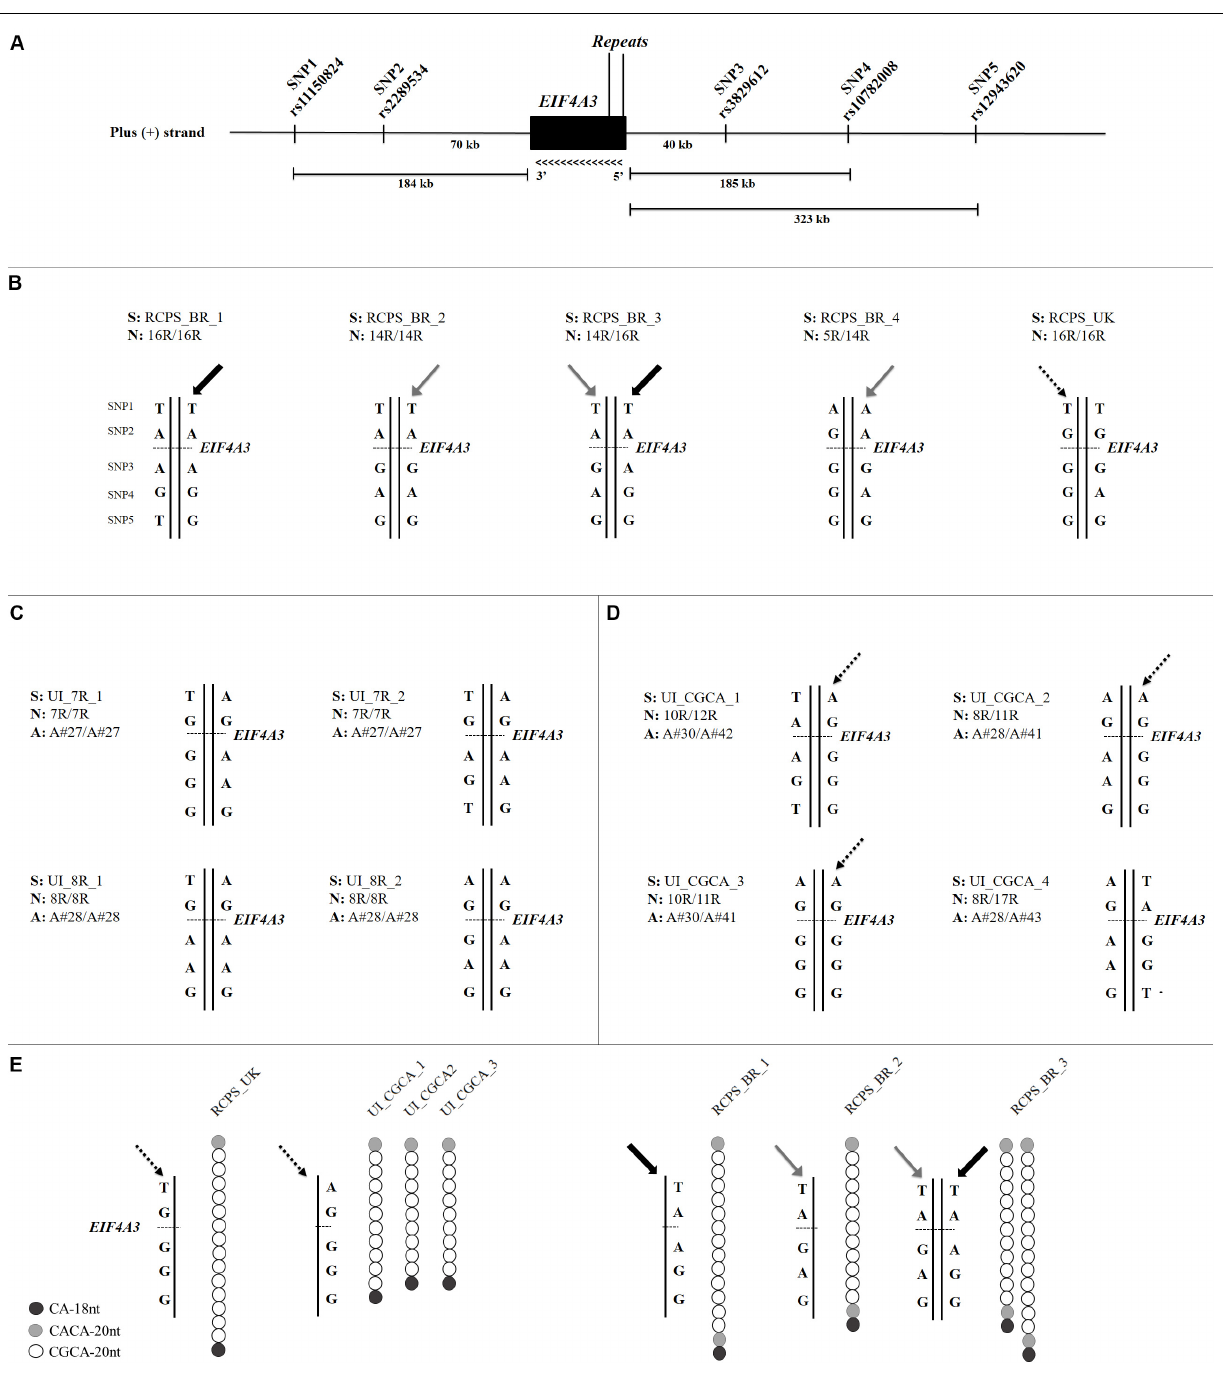
FIGURE 2 | (A) Schematic representation of the SNPs and microsatellite markers flanking EIF4A3 (11,970 bp). We used five SNPs for haplotype characterization and numbered them as following: SNP1 (rs11150824), SNP2 (rs2289534), SNP3 (rs3829612), SNP4 (rs10782008), and SNP5 (rs12943620), according to their relative genomic position on the annotated plus strand (GRCh38/hg38). (B) Haplotype analysis of five RCPS patients, four Brazilians, and one from the United Kingdom. Gray arrows indicate the haplotype associated with the 14-repeat alleles and black arrows indicate the haplotype associated with the 16-repeat alleles in Brazilian RCPS. UK RCPS presented a similar haplotype observed in the unaffected individuals with the disease CGCA-20nt motif (dotted arrow). (C) Haplotype analysis of four unaffected individuals without the disease CGCA-20nt motif. These individuals are homozygous for seven or eight repeats. (D) Haplotype analysis of four unaffected individuals with the disease CGCA-20nt motif. Dotted arrows indicate the haplotype present in three of these individuals. (E) Comparison between haplotypes of the UK RCPS patient, the three unaffected individuals with the CGCA-20nt motif and the three Brazilian RCPS patients. S is the sample ID, N is the total number of repeats for each allele and A is the allele structure ( Figure 1 and Supplementary Table S2 ). Each bar represents an allele.